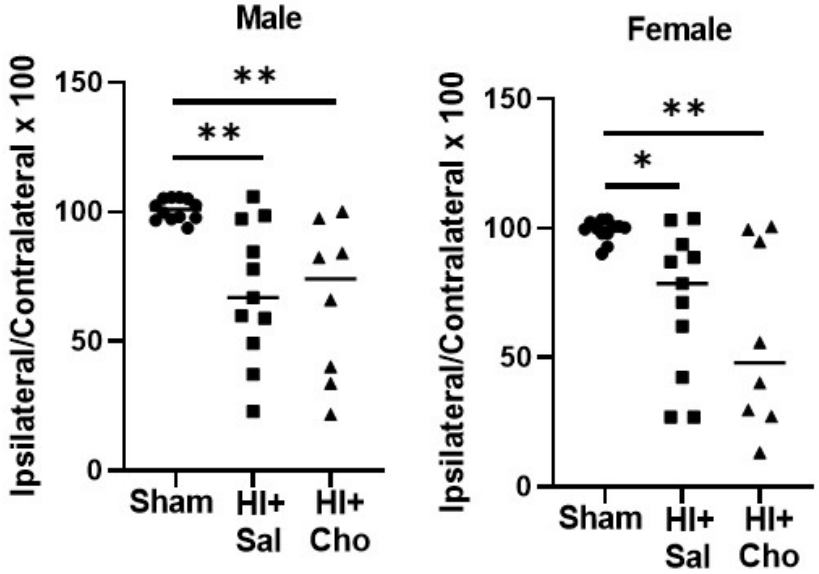
Figure 6. Choline did not significantly improve long-term histological outcomes in males or females. Cerebral hemisphere volume was measured in young adult rats tested behaviorally after HI on PND10. The area of the contralateral and ipsilateral hemispheres was measured in 3 sections through the dorsal hippocampus. In both males and females, HI groups differed from sham controls regardless of saline or choline treatment, * p < 0.05, ** p < 0.01 Data are expressed as area of the ipsilateral/area of contralateral × 100. HI = hypoxia ischemia; Sal = Saline; Cho = Choline.